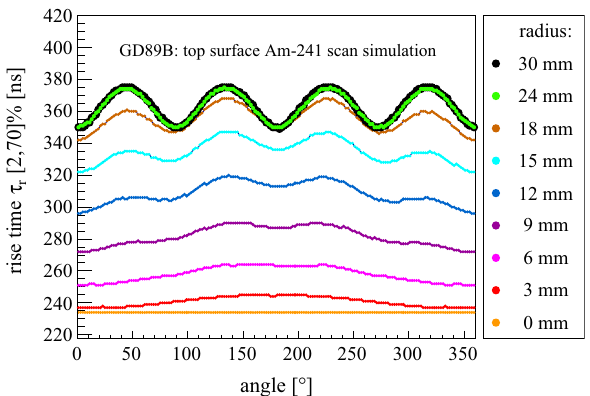
Fig. 13 Detector GD89B: ADL3 -based simulation of rise time curves of circular scans on the top diode surface using the τ r ([2,70]%) defini- tion